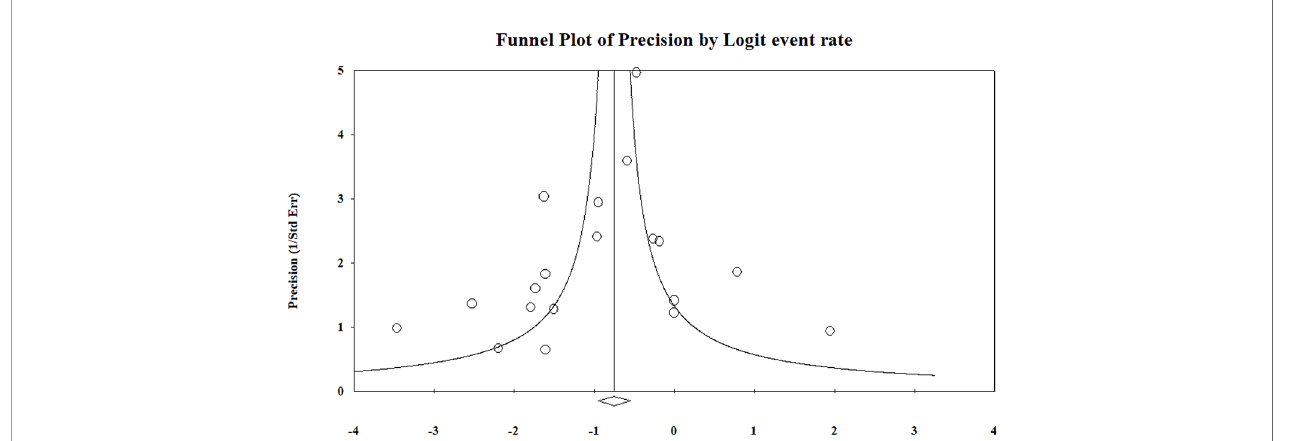
FIGURE 3 | Summary of the funnel plot of conservative treatment recurrence